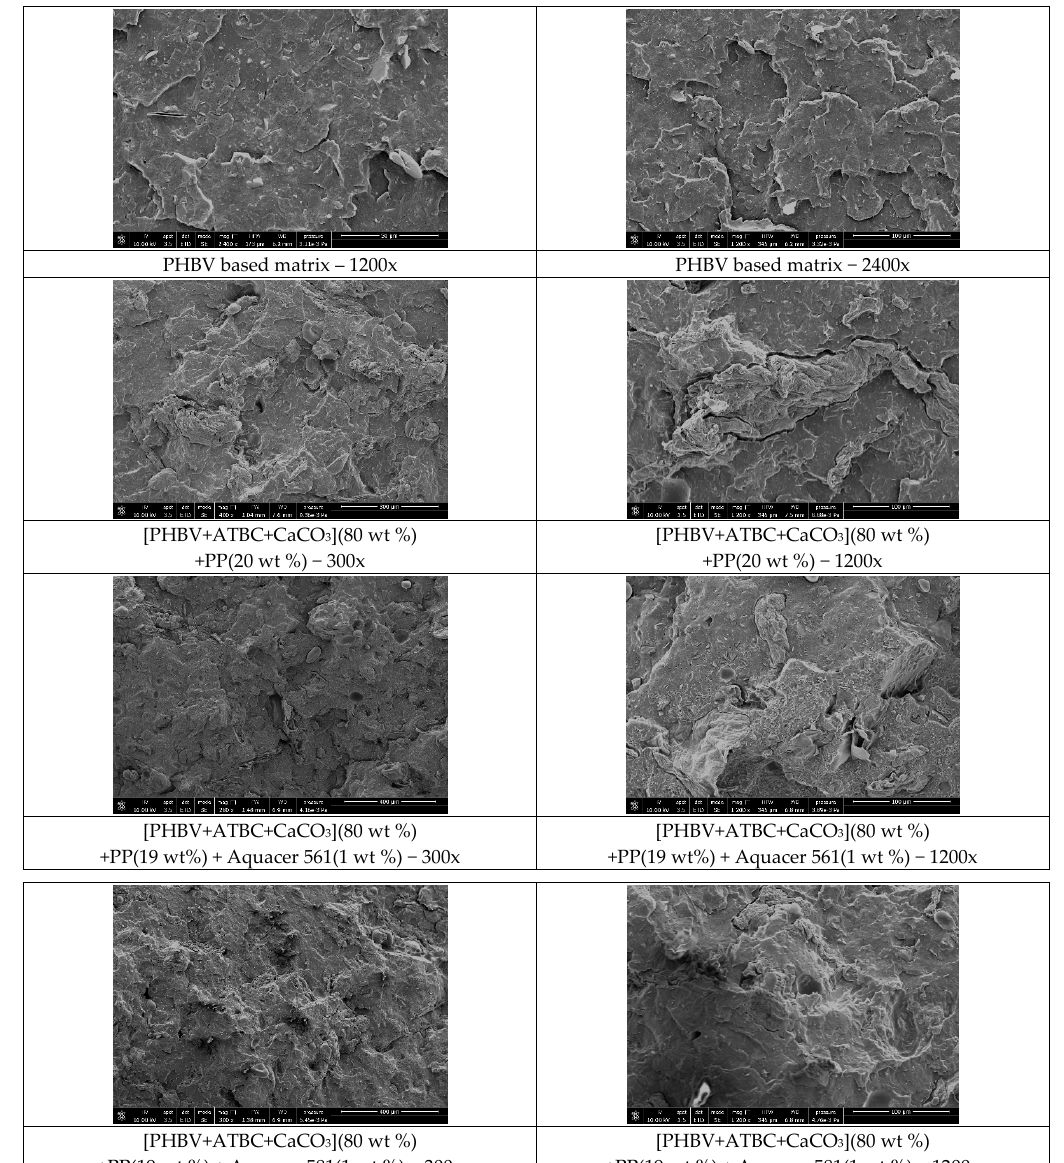
Figure 7. SEM images of the PHBV based matrix and biocomposites at the indicated magnification.